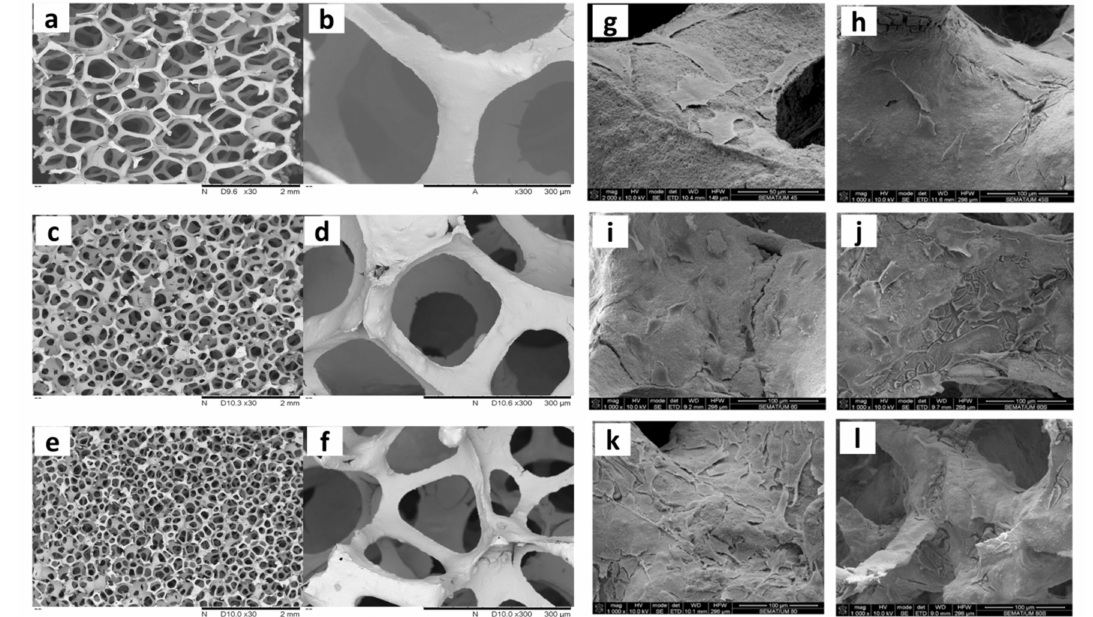
Figure 3. SEM images of 3D zirconia scaffolds ( a , b ) 564-Z, ( c , d ) 423-Z and ( e , f ) 318-Z at low (left) and high (right) magnifications. SEM images of MG-63 osteoblast-like cells on the uncoated 564-Z, 423-Z and 318-Z ( g , i , k ) and coated 564-Z.BG, 423-Z.BG and 318-Z.BG ( h , j , l ) scaffolds after 2 d of cultivation. Images used from Guimaraes et al. [55] reprinted with permission from Elsevier, copyright©